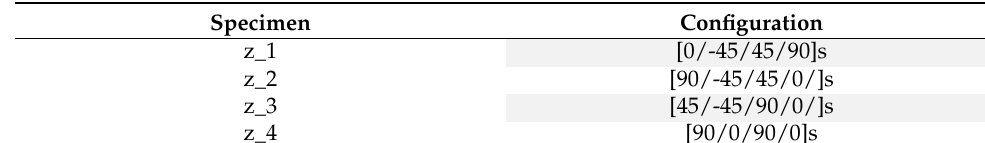
Table 1. Composite layup configurations.